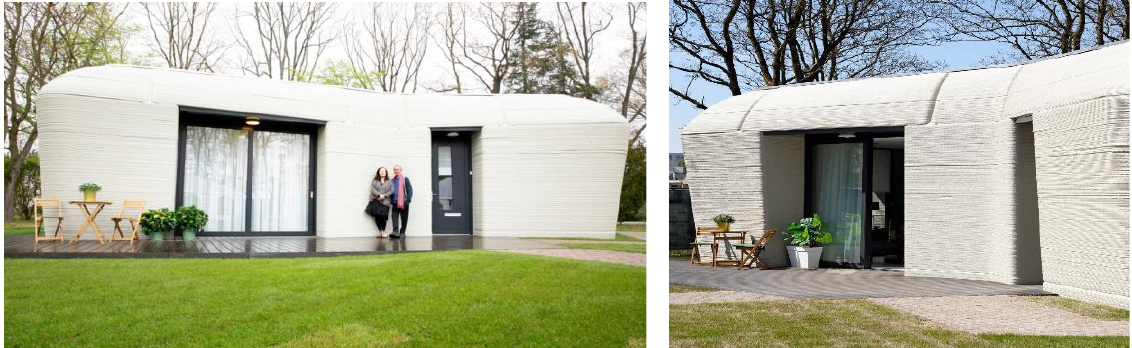
Figure 9: The Europe’s first inhabited 3D -printed house